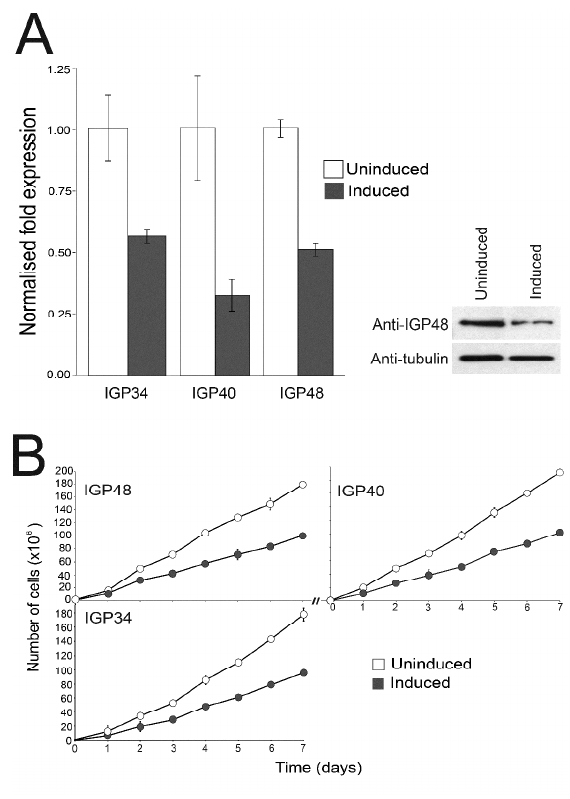
FIGURE 3: IGP40 and IGP48 are required for normal cell prolifer- ation. (A) qRT-PCR of control and tetracycline-induced RNAi lines for IGP34, IGP40 and IGP48 24 hours post-induction (n = 3). Right panel shows a Western blot of IGP48 following RNAi induction after 24 hours with β-tubulin as loading control. (B) Growth curves of control and tetra-cycline-induced RNAi lines for IGP34, IGP40 and IGP48, showing a growth defect within 24 hours post induction. Representative results for one of two clonal cell lines for each construct studied are shown (n = 2) (all subsequent ex- periments were performed using this cell line). Cultures were diluted daily to maintain cell densities between 10 5 and 2 × 10 6 cells/ml, and a cumulative pseudo-growth curve is shown. Counts were carried out in triplicate, error bars represent standard error of the